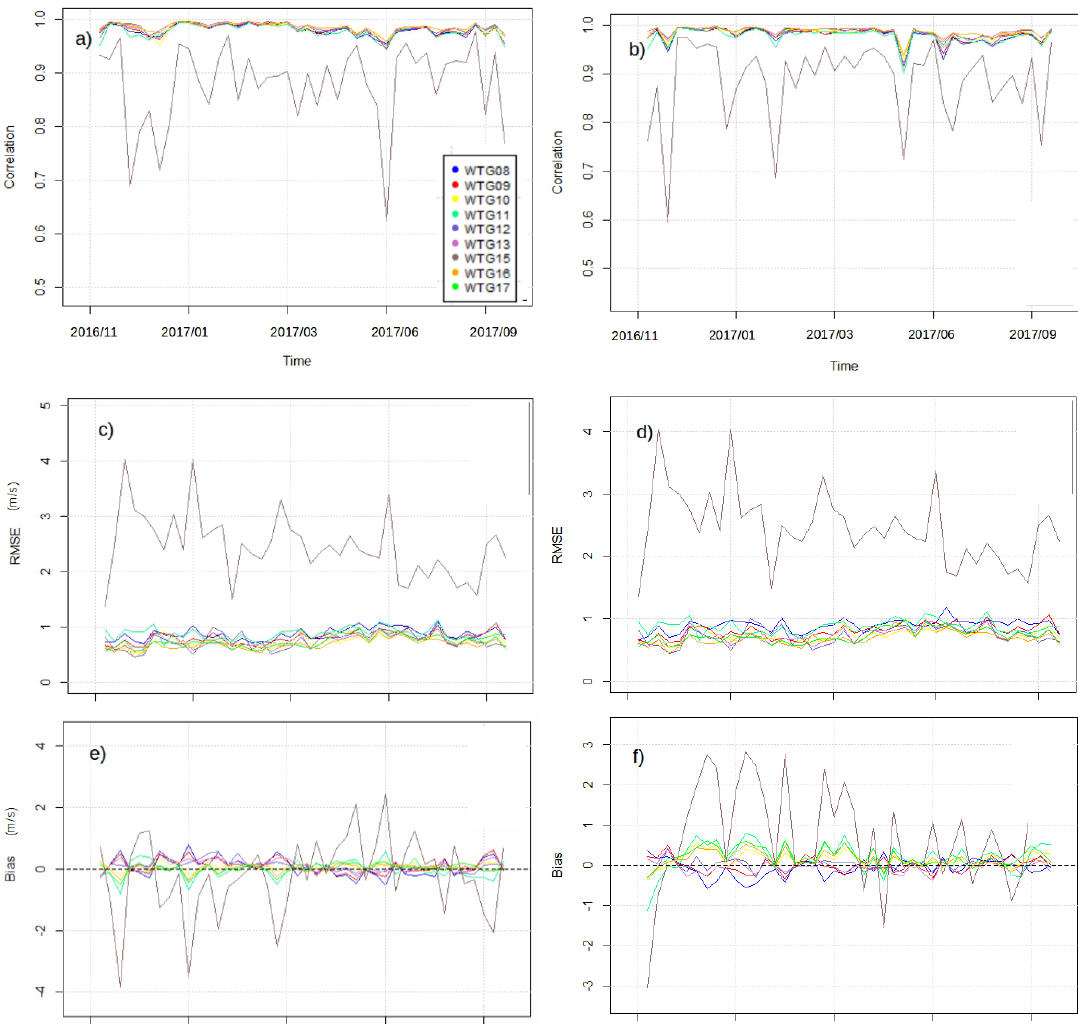
Figure 7. Running correlation of: ( a ) zonal component and ( b ) meridional component. Running RMSE of: ( c ) zonal component and ( d ) meridional component. Running bias of: ( e ) zonal component and ( f ) meridional